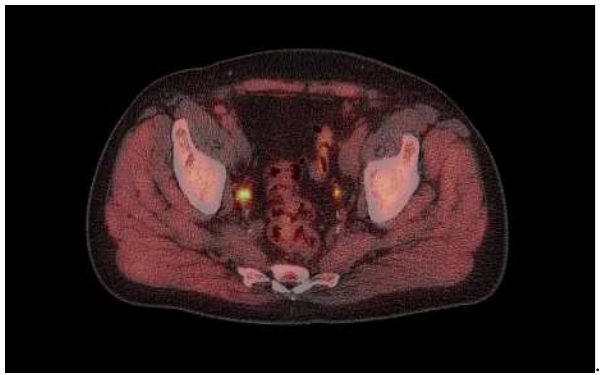
Figure 1. 18F-fluciclovine PET example image. Image captured from a 74-year-old male showing 18 F-fluciclovine-avid lesion in right side iliaca interna lymph node (SUV 12).